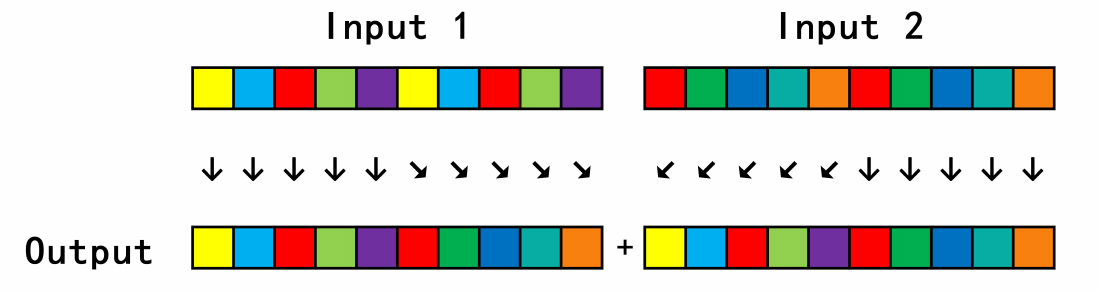
Figure 11. Stream ConCat